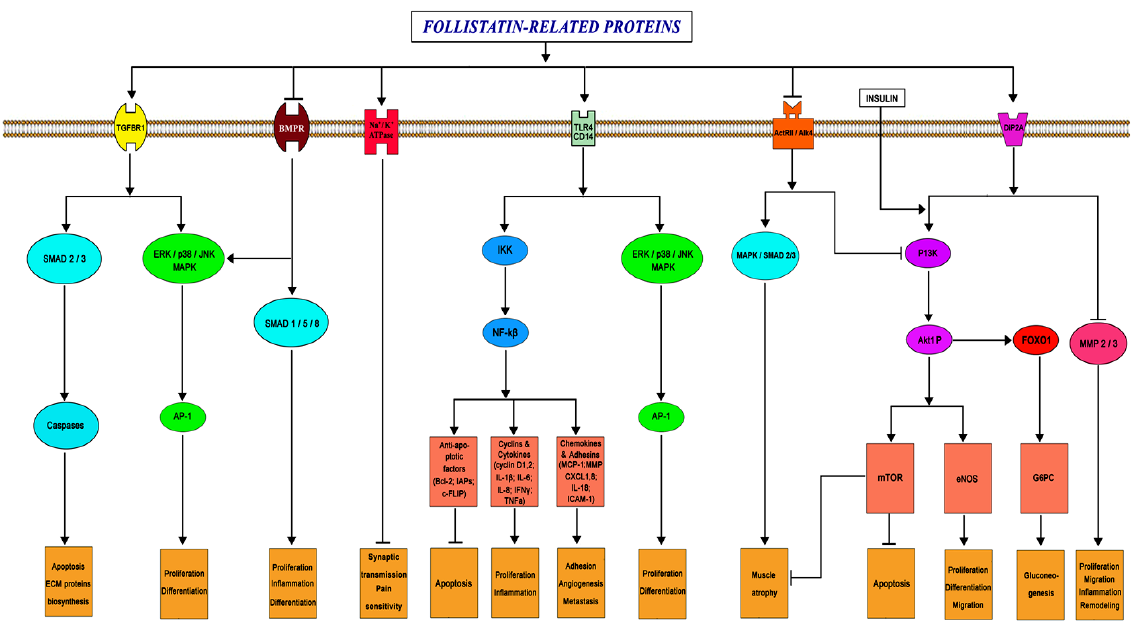
Figure 3. Simplified diagram of the main signaling pathways characteristic of follistatin-like proteins (arrows imply activation of the pathway) [7,10,12,21–32,49].